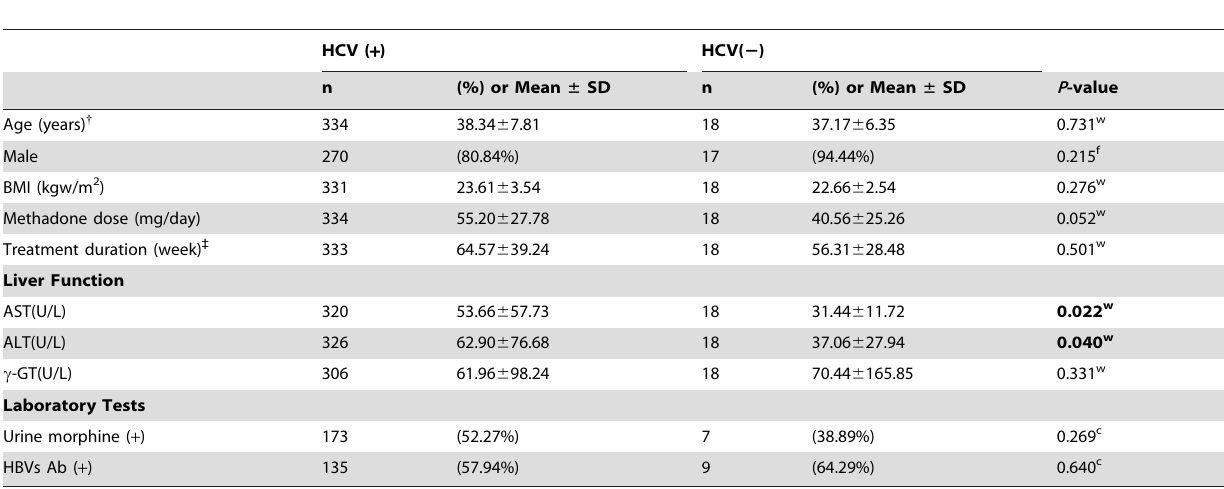
Table 1. Demographics and laboratory findings for MMT study subjects, classified by viral hepatitis C virus